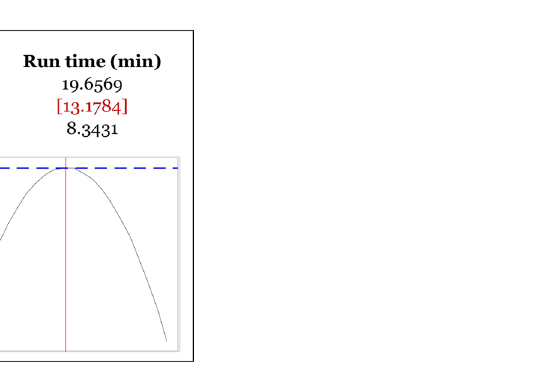
Figure 6. Optimization diagrams calculated mathematically.